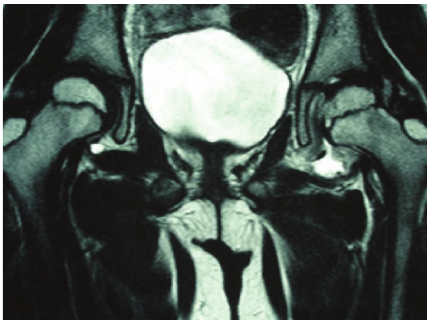
Figure 3: Coronal, T2-weighted magnetic resonance imaging scan of the hip joints 2 months after the initial visit. A linear low-signal- intensity region was found at the left femoral capital epiphysis.